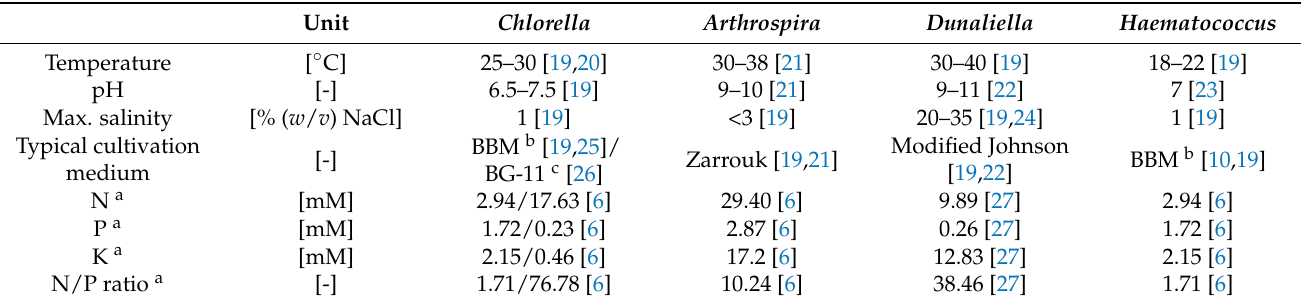
Table 1. A coarse overview over typical cultivation variables for commercially popular genera such as Chlorella , Arthrospira , Dunaliella , and Haematococcus